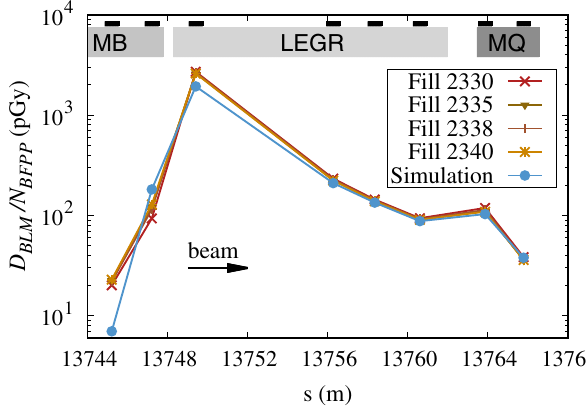
FIG. 17. Simulated and measured BLM signals for 1 . 38 A TeV 208 Pb 81 þ ion losses in the dispersion suppressor next to IR5. The measurements were recorded during different fills in 2011. Signals are normalized to the number of bound-free pair productions per beam in IP5. The beam direction is from the left to the right. Statistical errors of simulation results are less than 10% for BLMs downstream of the assumed loss location ( s ≈ 13748 m), while they are up to 20% for upstream